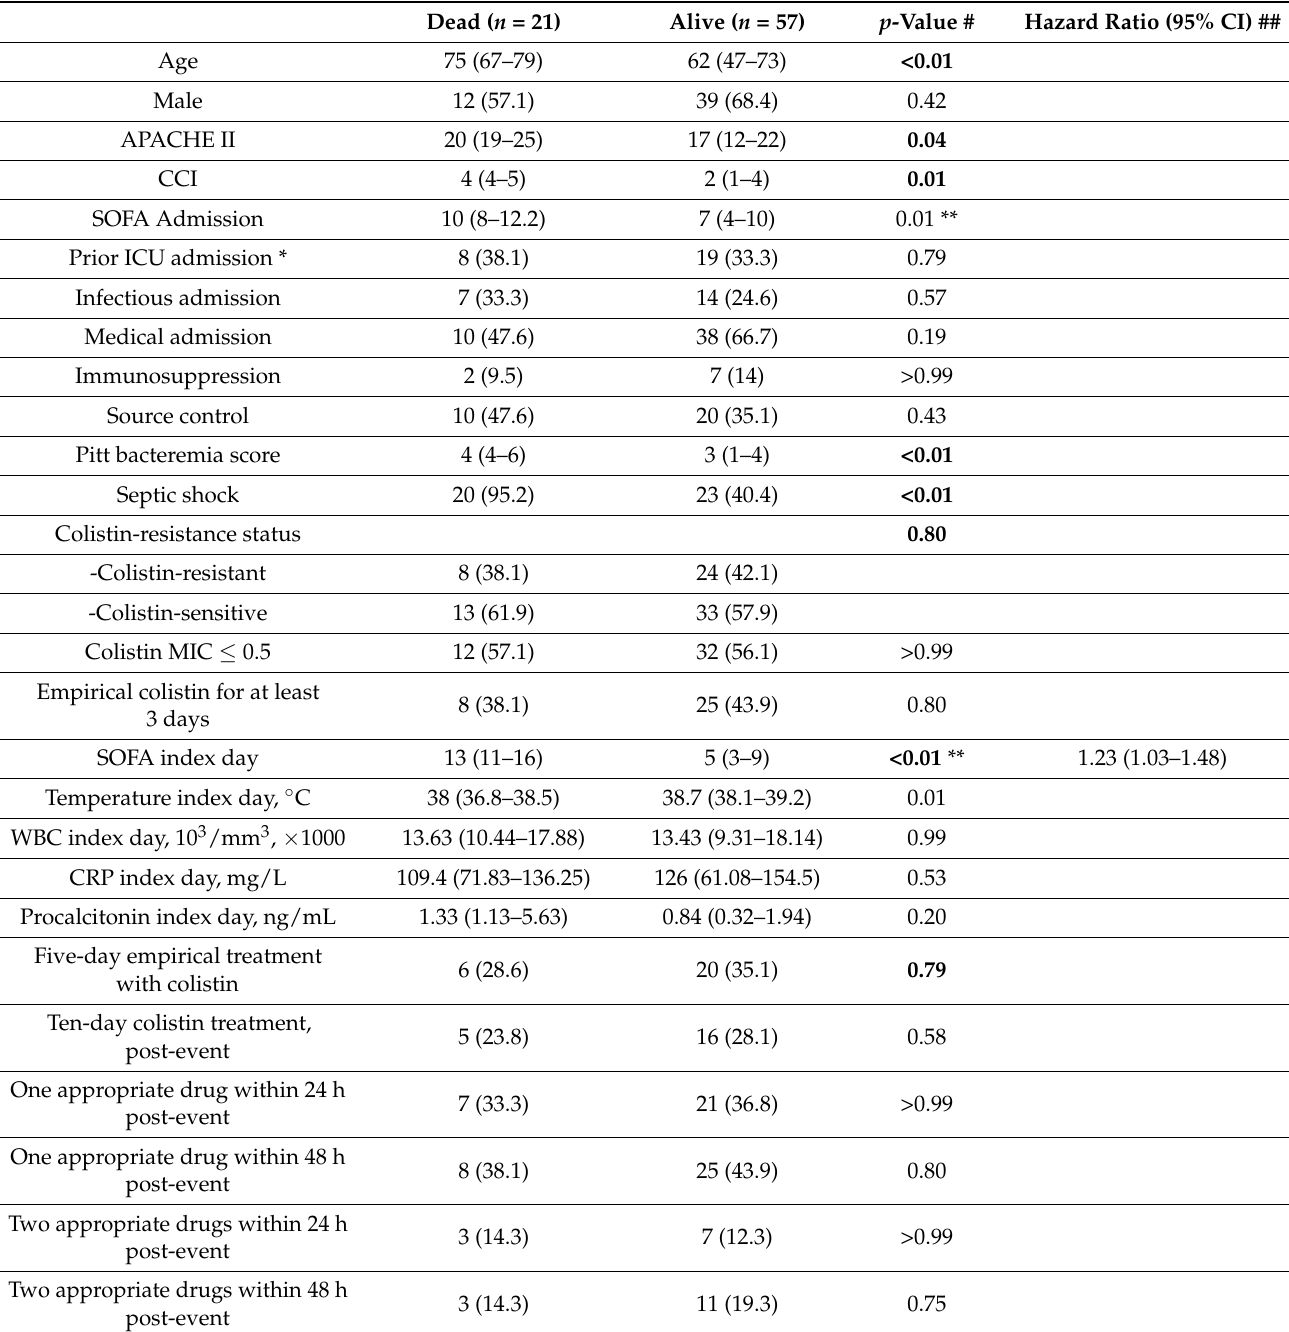
Table 3. Factors associated with 28-day